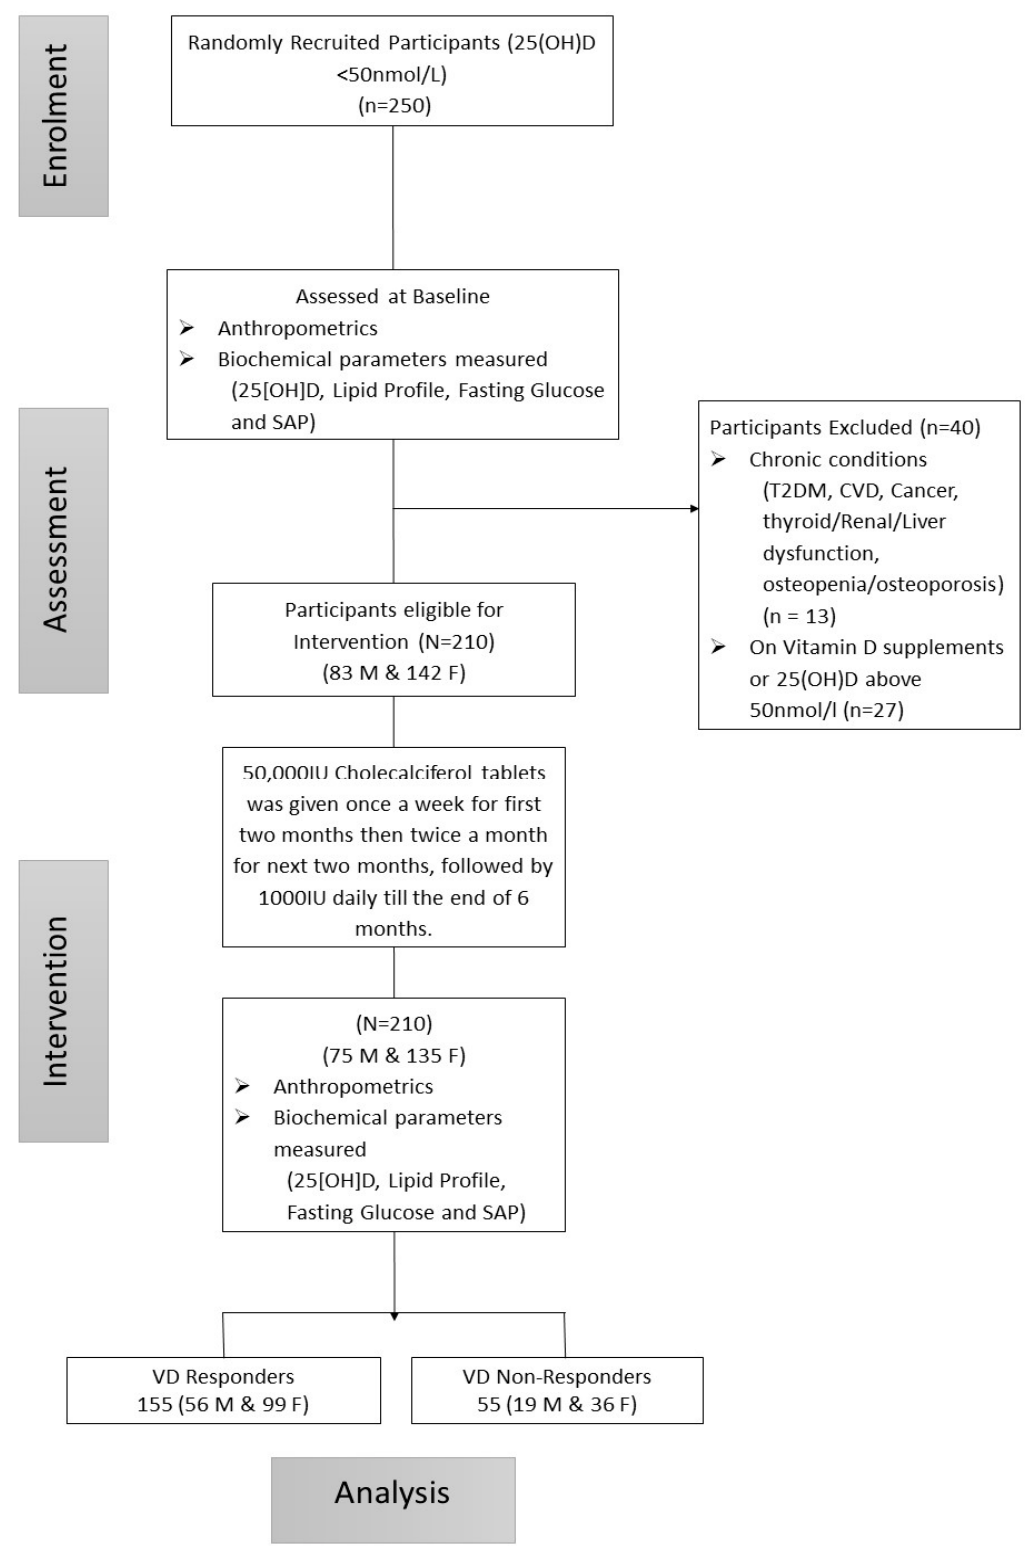
Figure 1. Participant flow chart.